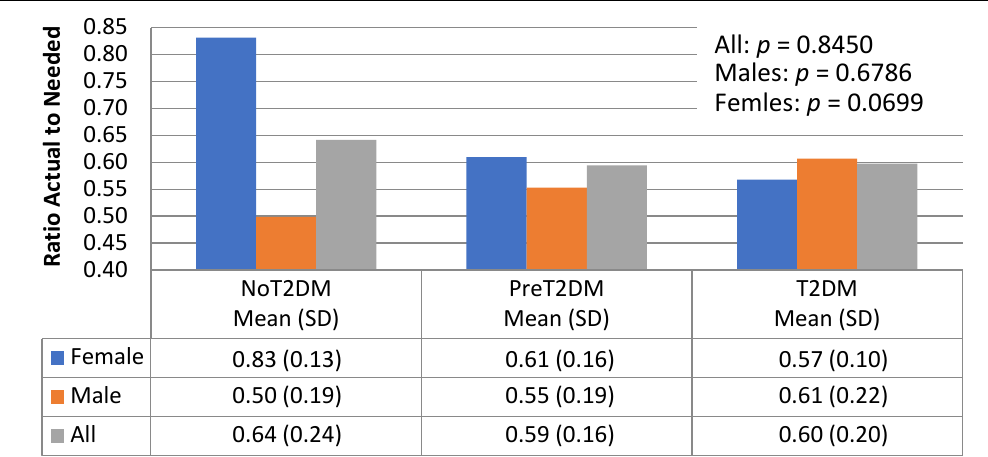
Figure 6. Actual to needed total kilocalories by diabetes status and gender.